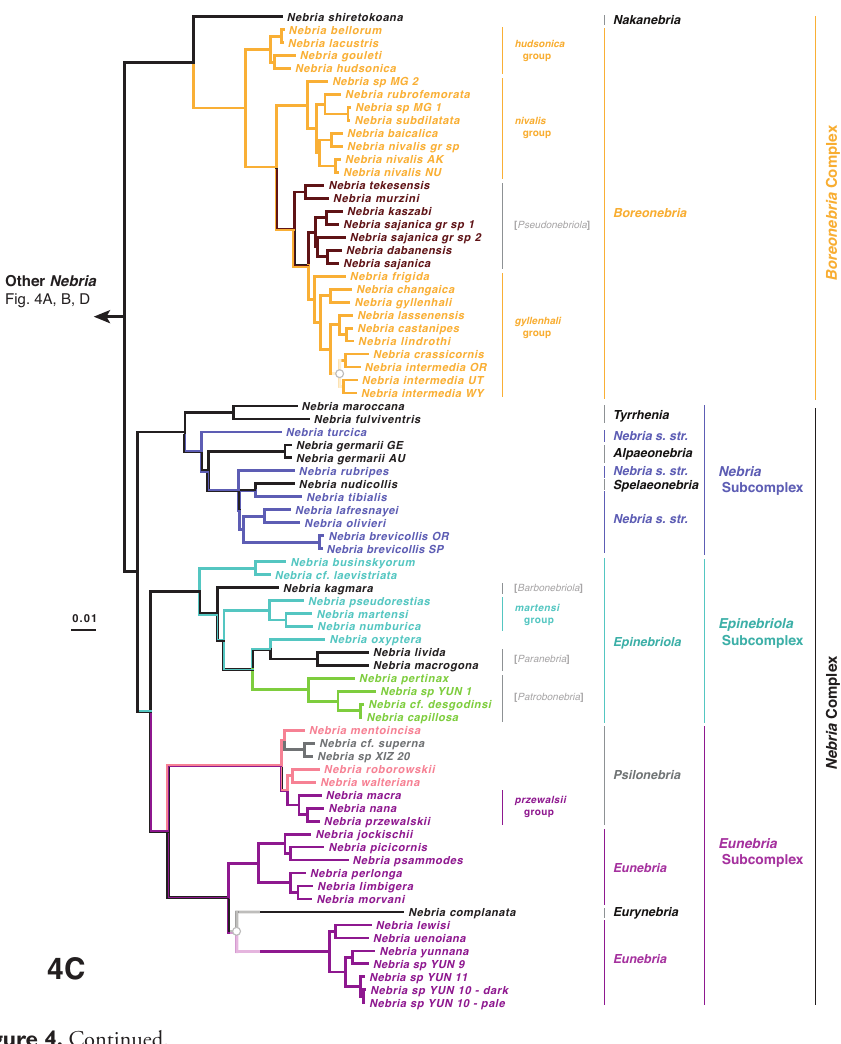
Evanoleistus species excluding L. sp NEP (Chart 1, line 23) is strongly supported in all concatenated gene analyses, including the Mito G analysis, in all three mitochondrial and in the wg single-gene analysis, but it is only moderately supported in CAD2 and PEPCK analysis and contradicted in the 28S and Topo analyses. The above results suggest that on to all our other Evanoleistus or an outlier related more closely to one or more species of Leistus s. str. As the only Himalayan species in our sample out of the 18 species described in Evanoleistus from that region, it may represent a more diverse lineage with relationships intermediate between Evanoleistus and Leistus s. str. We therefore include L. sp NEP in an unresolved trichotomy in our summary tree (Fig. 6) to reflect this ambiguity. Molecular data from additional members of the Himalayan fauna may help clarify